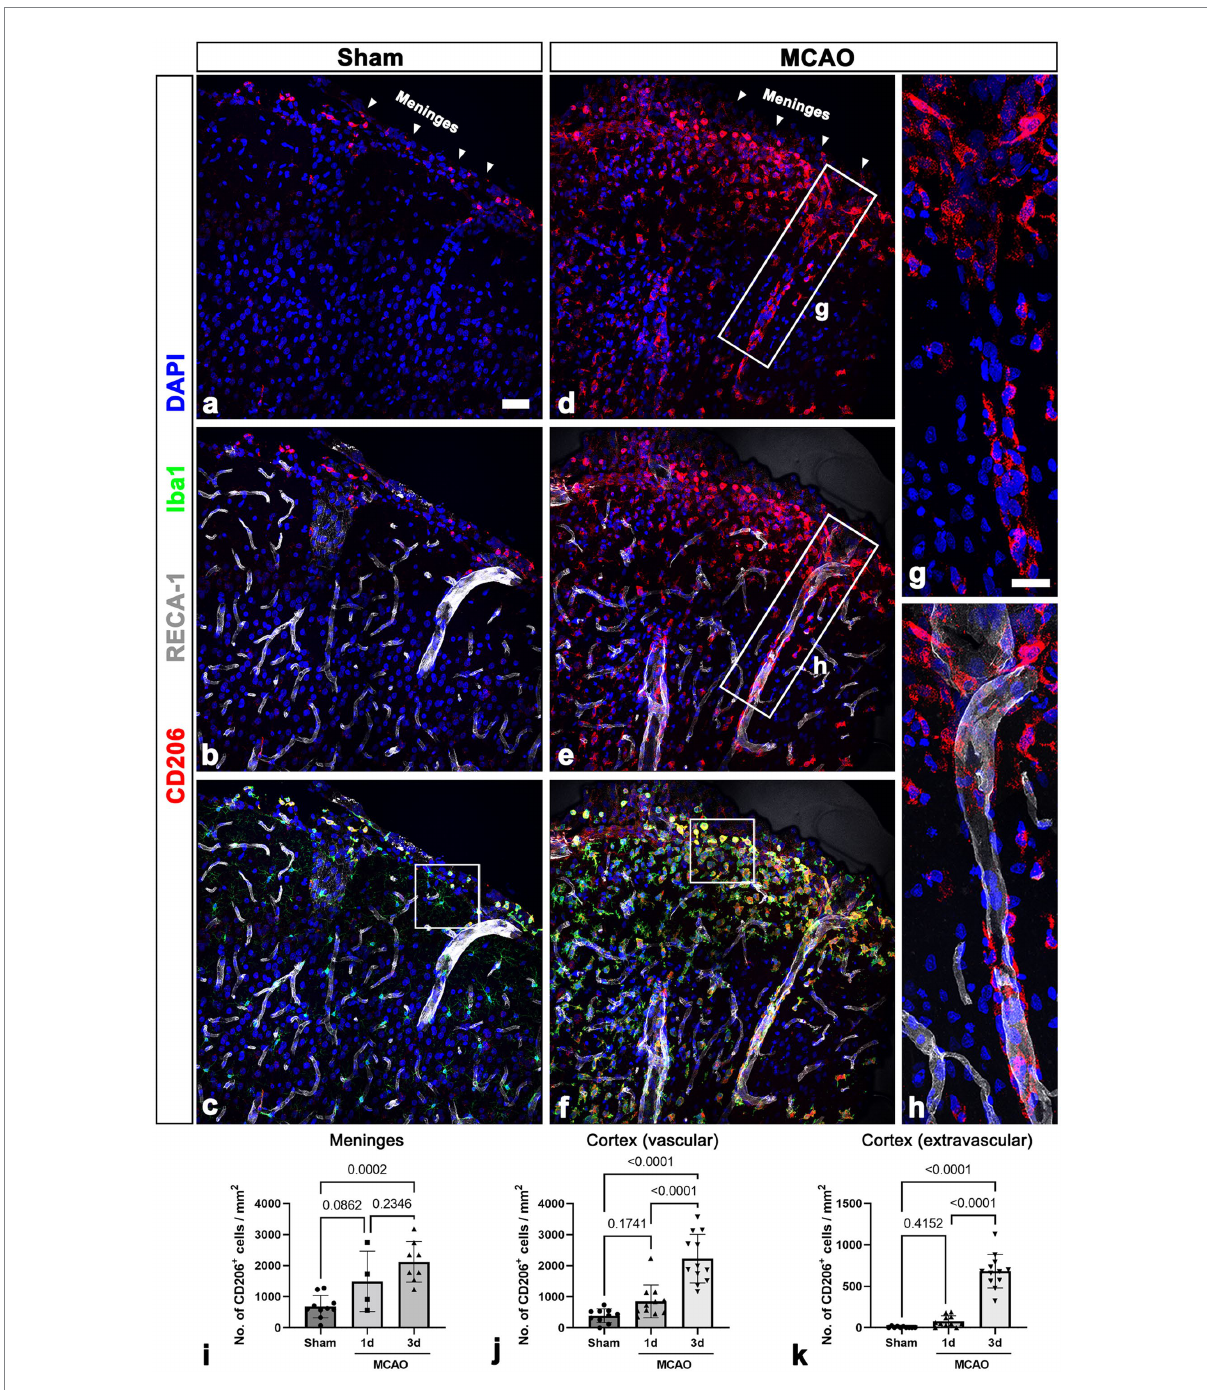
FIGURE 1 CD206-positive macrophages in the leptomeninges and the underlying cerebral cortex in sham-operated and MCAO rats. (A–C) Triple labeling for CD206, the endothelial cell marker RECA-1, and Iba1 in control sections showing that CD206/Iba1 double-labeled macrophages are occasionally observed in the leptomeninges (arrowheads in a) and large cortical penetrating vessels but not in the cortical parenchyma. (D–F) Triple labeling for CD206, RECA-1, and Iba1 in the cortex reperfused for 3 days showing that CD206/Iba1 double-labeled macrophages have accumulated at the leptomeninges (arrowheads in D ) and in the superficial cortical parenchyma. Note that these macrophages are associated with penetrating large- sized cortical vessels. (G,H) Higher magnification views of the boxed areas in d and e, respectively. CD206-positive macrophages with elongated morphologies are located along the wall of penetrating cortical vessels. (I–K) Quantitative temporal analysis showing that the number of CD206- positive macrophages is significantly increased in the leptomeninges and cortex including the vascular and surrounding extravascular areas 3 days after ischemia ( n = 3 sections from 4 to 12 rats per time points, one-way ANOVA with Tukey’s multiple comparison test). Data are expressed as the mean ± SEM, and numbers on each bar graph indicate p values. Scale bar = 50 μ m for a–f, 25 μ m for (G,H)